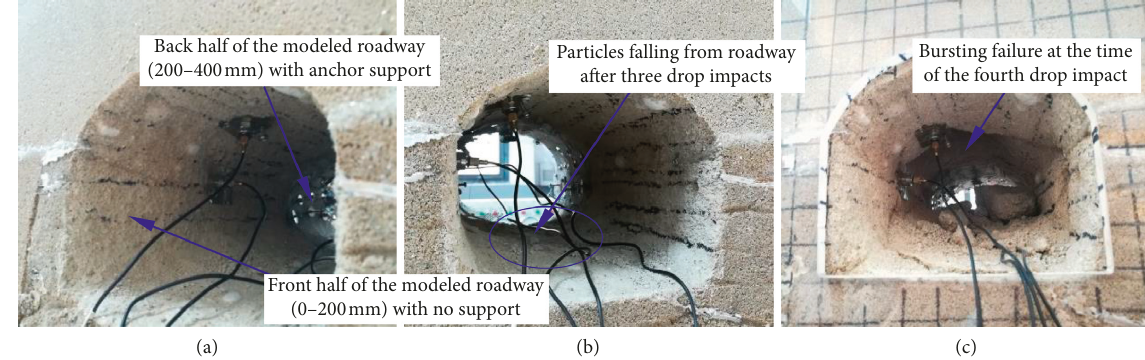
Figure 8: Photographs of the modeled roadway before drop impacts (a), after three drop impacts (b), and after the fourth drop impact